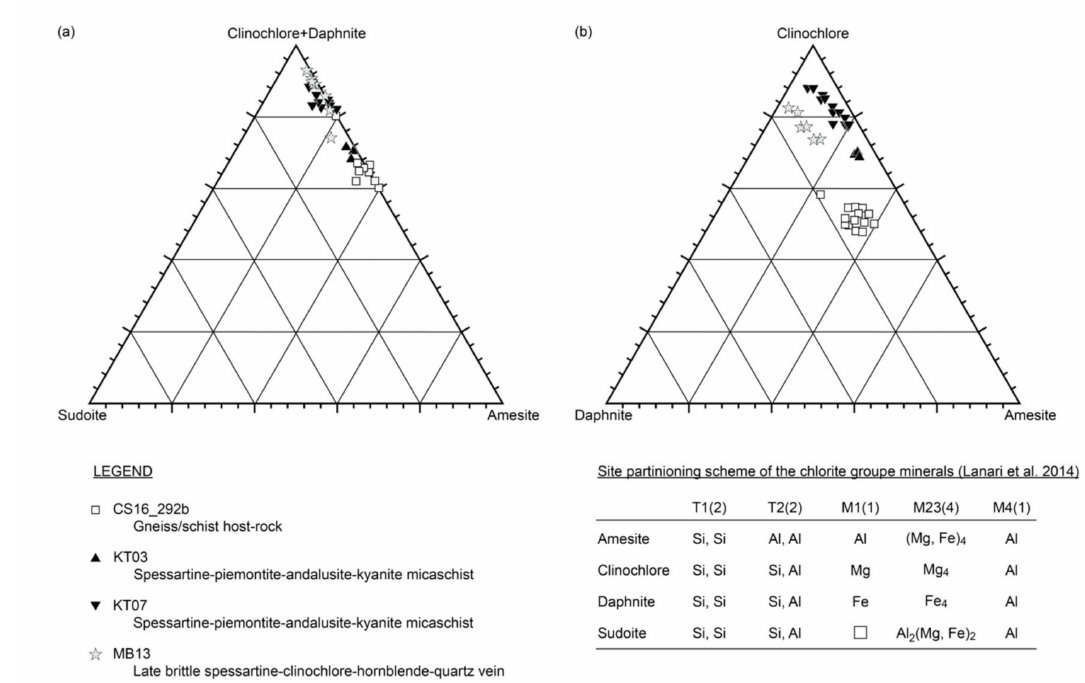
Table S9: EPMA analyses TITANITE-RUTILE, Table S10: EPMA analyses MnOXIDES, Table S11: EPMA analyses CHLORITE, Table S12: EPMA analyses KYANITE, Table S13: EPMA analyses ANDALUSITE.